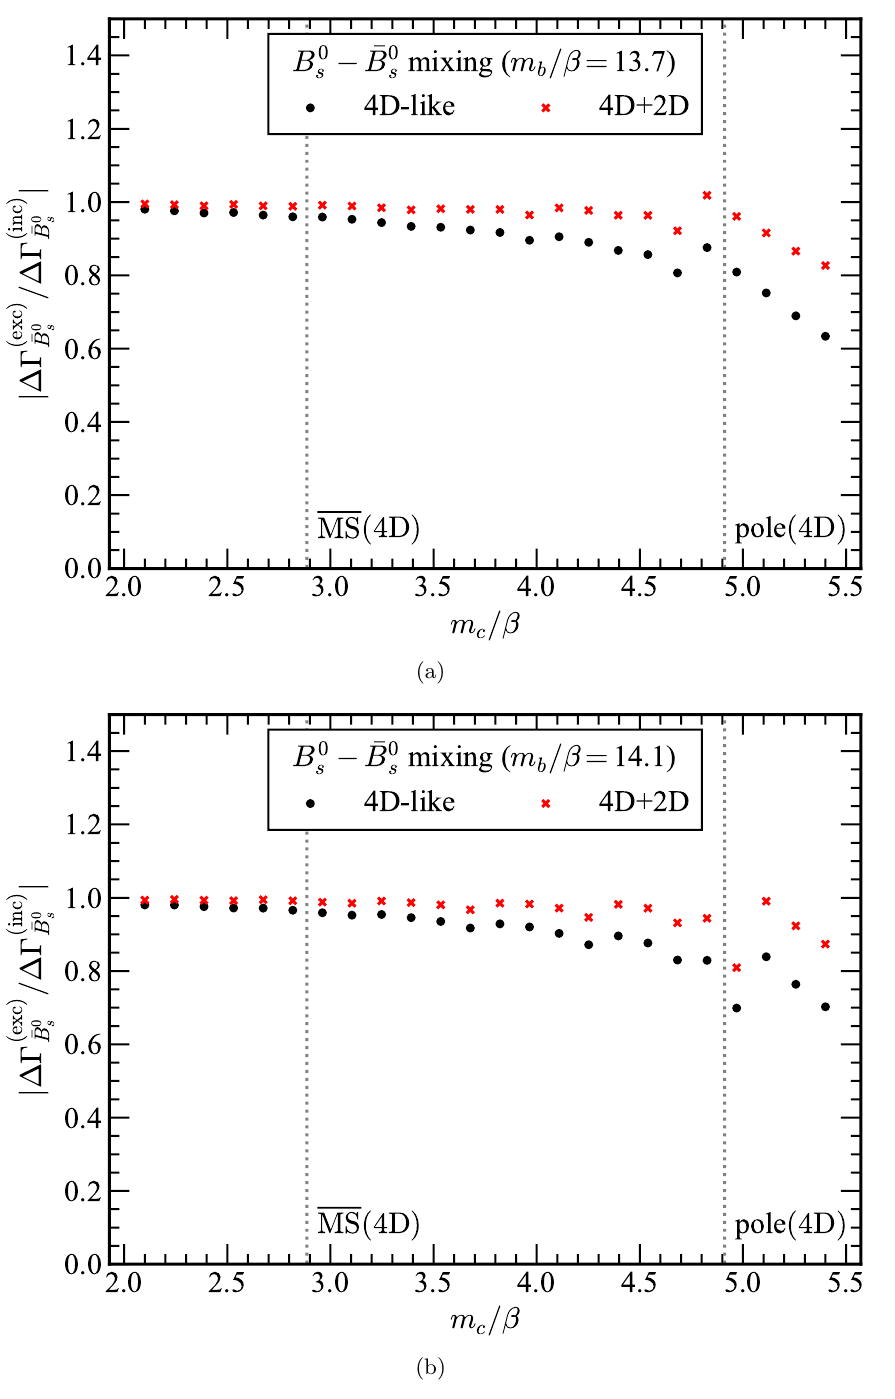
¯ mixing: (a) m − B 0 s s